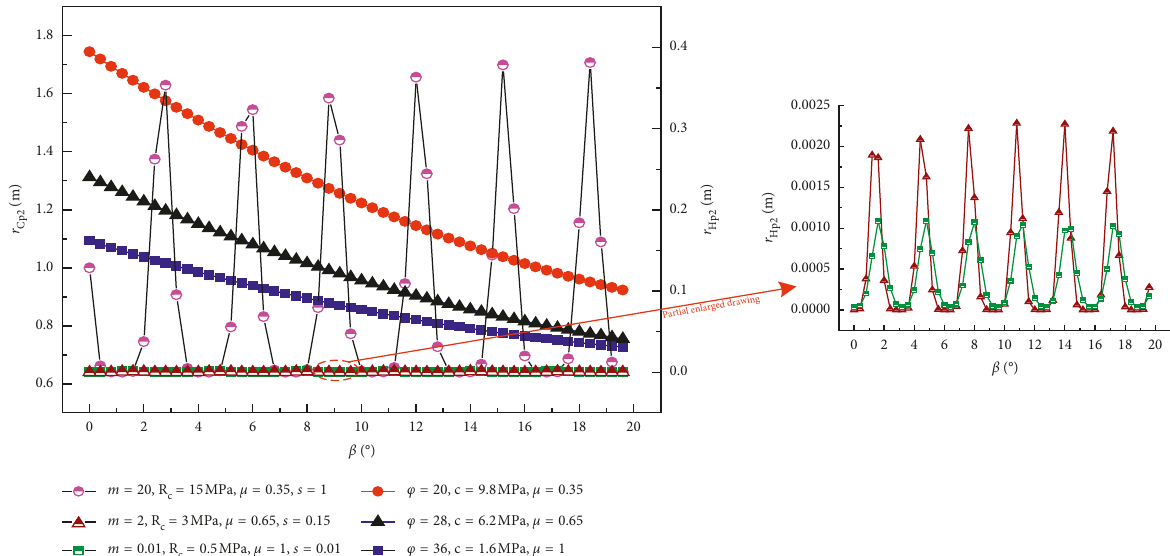
Figure 8: The influence curve of damaged width of rib pillar by the dip angle of coal